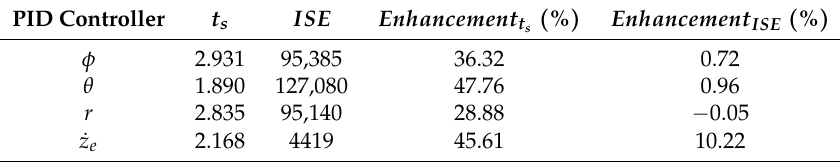
Table 4. Controller performance using a genetic